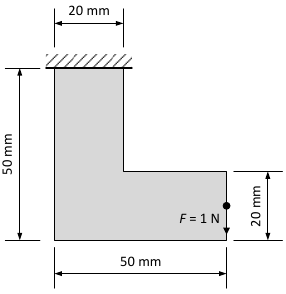
Figure 8. Dimensions of the design domain with loading and boundary conditions for a L-shaped beam.